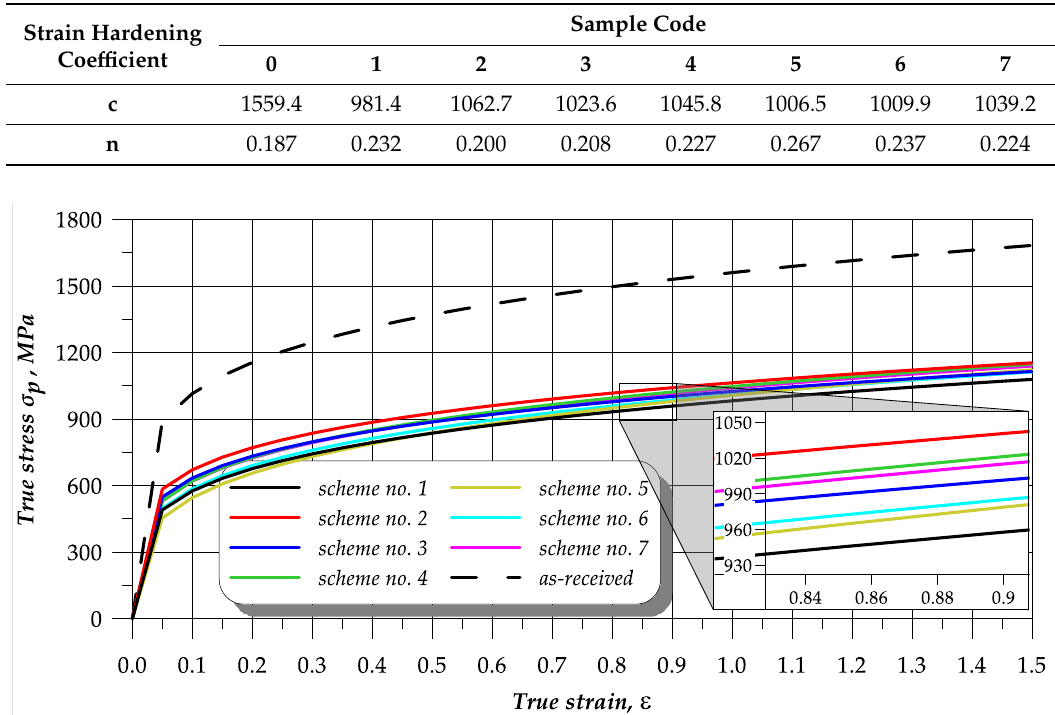
Figure 10. Upsetting flow curves of as-received (0) and annealed (schemes no. 1–7) 42CrMo4 steel.